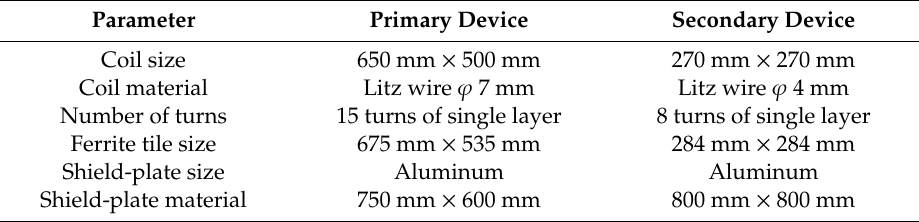
Table 3. Parameter of the primary and secondary